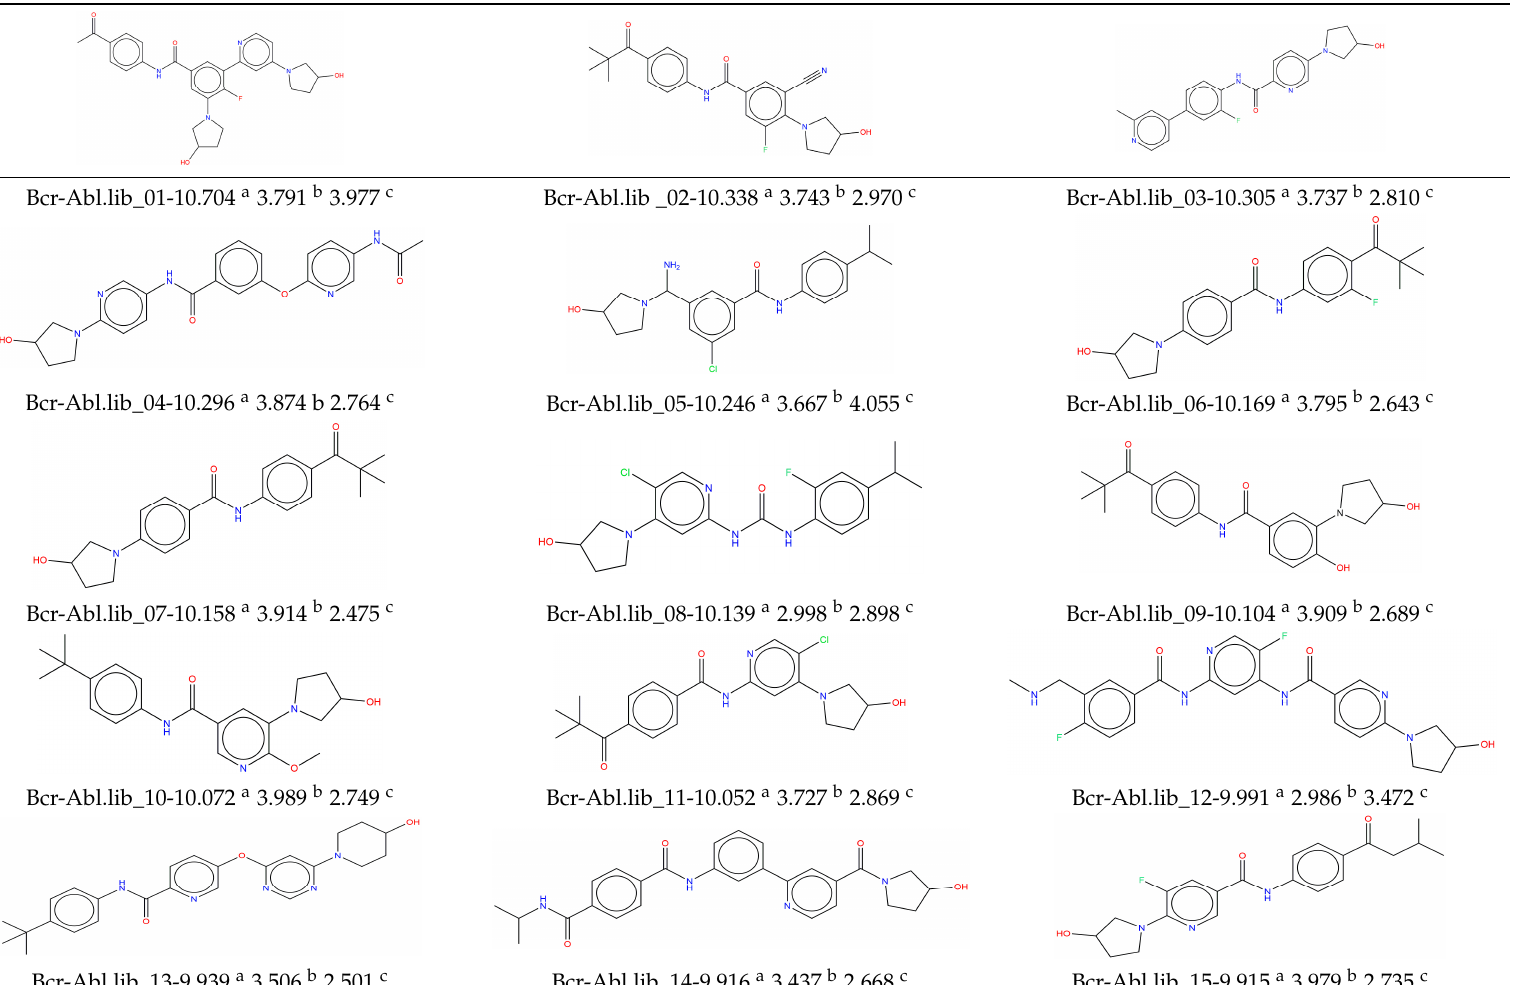
Table 1. Representative examples of 15 top-ranked potential inhibitors generated through automated de novo drug design. The superscript letters a, b and c indicate the docking scores (kcal/mol), multi-objective S(x) fitness values, and Synthetic Accessibility (SA) score, respectively.